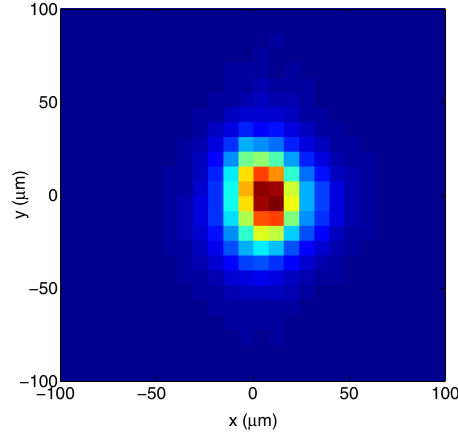
FIG. 47. Example of a beam-size measurement for a bunch charge of 6 pC performed with the novel transverse profile imager. The horizontal and vertical rms beam sizes obtained from Gauss fits are about 15 and 20 μ m, respectively.